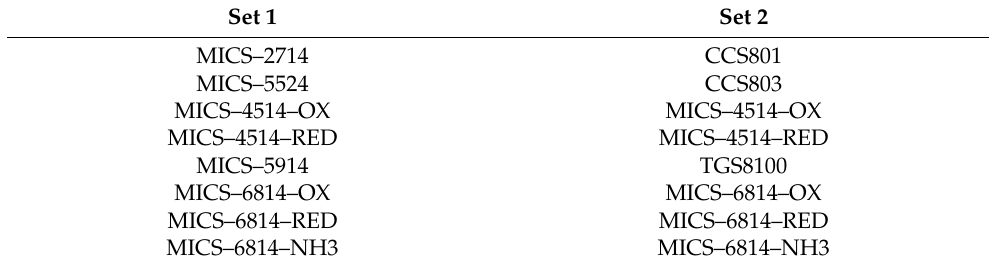
Table 1. Sensor setup.